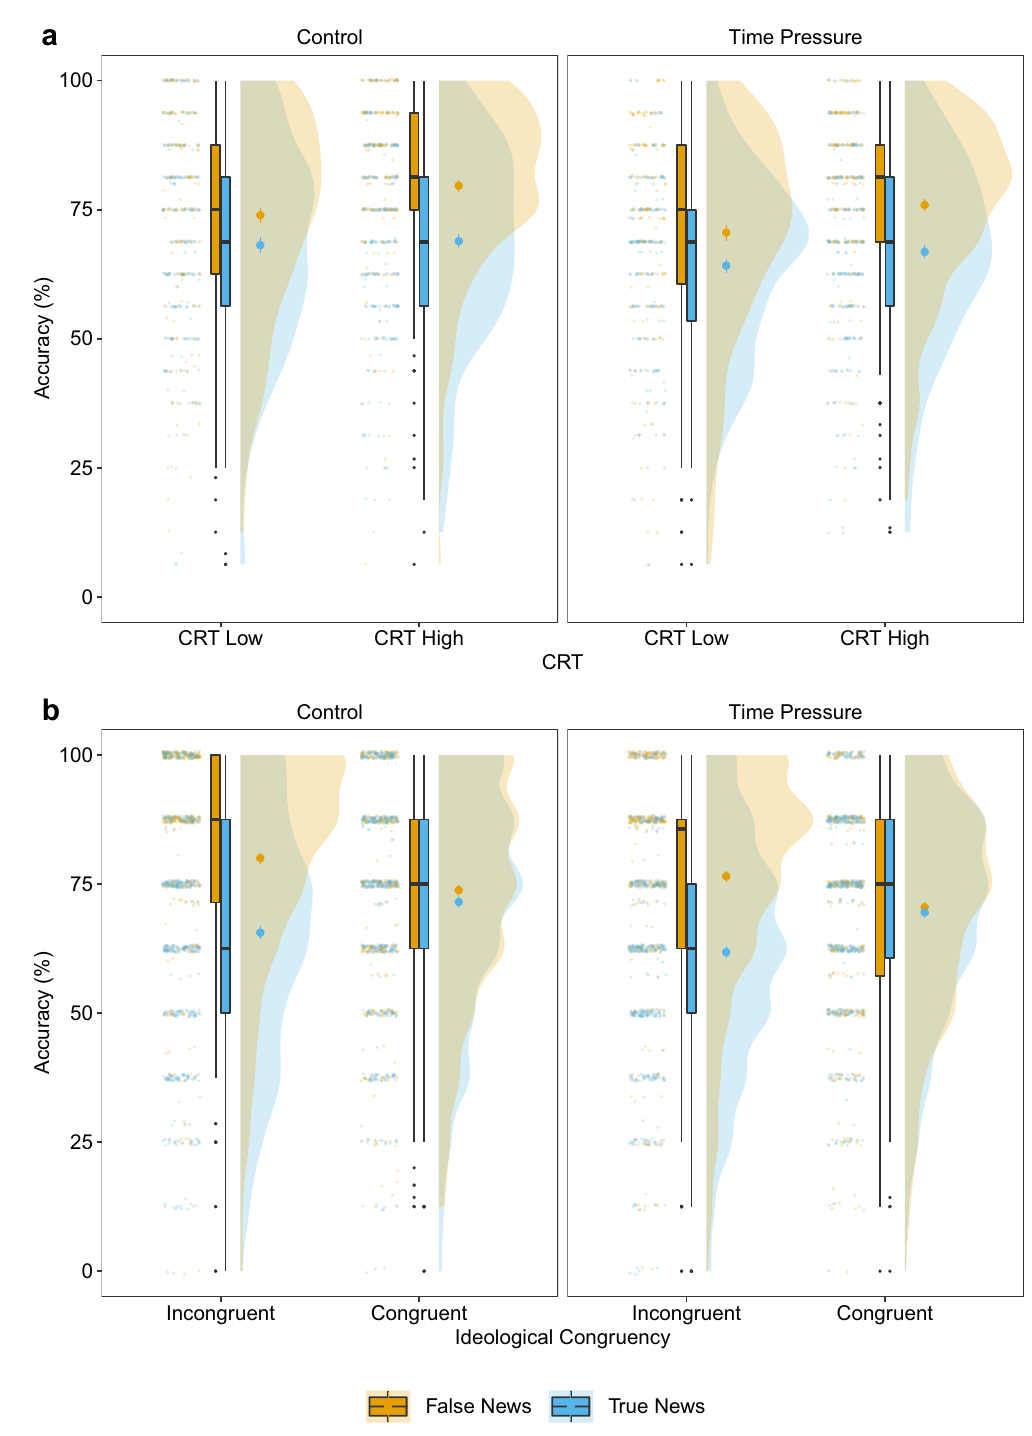
Figure 4. Accuracy for false and true news headlines by CRT scores ( a ) and ideological congruency ( b ) per treatment. CRT scores are shown as High and Low for visualisation purposes but were treated as standardised percentage scores in the analyses. Participants with three or more correct responses were classified as having a High CRT score; participants with two or fewer correct responses as having a Low CRT score. The small coloured dots represent the mean accuracy of each individual. The boxplots show the median value and the IQR. The whiskers indicate an additional 1.5 IQR and the small black dots represent outliers. The large coloured dots represent the aggregate mean with standard errors. The density plots describe the distribution of the